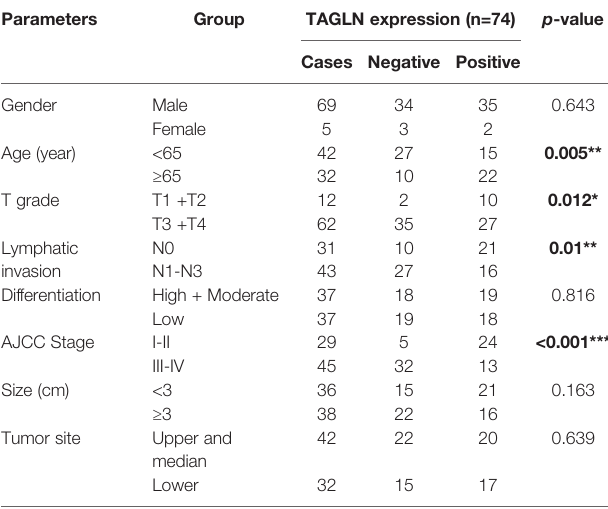
TABLE 1 | Clinical data were analyzed to investigate the relationship between the expression of Transgelin and pathological characteristics. Parameters